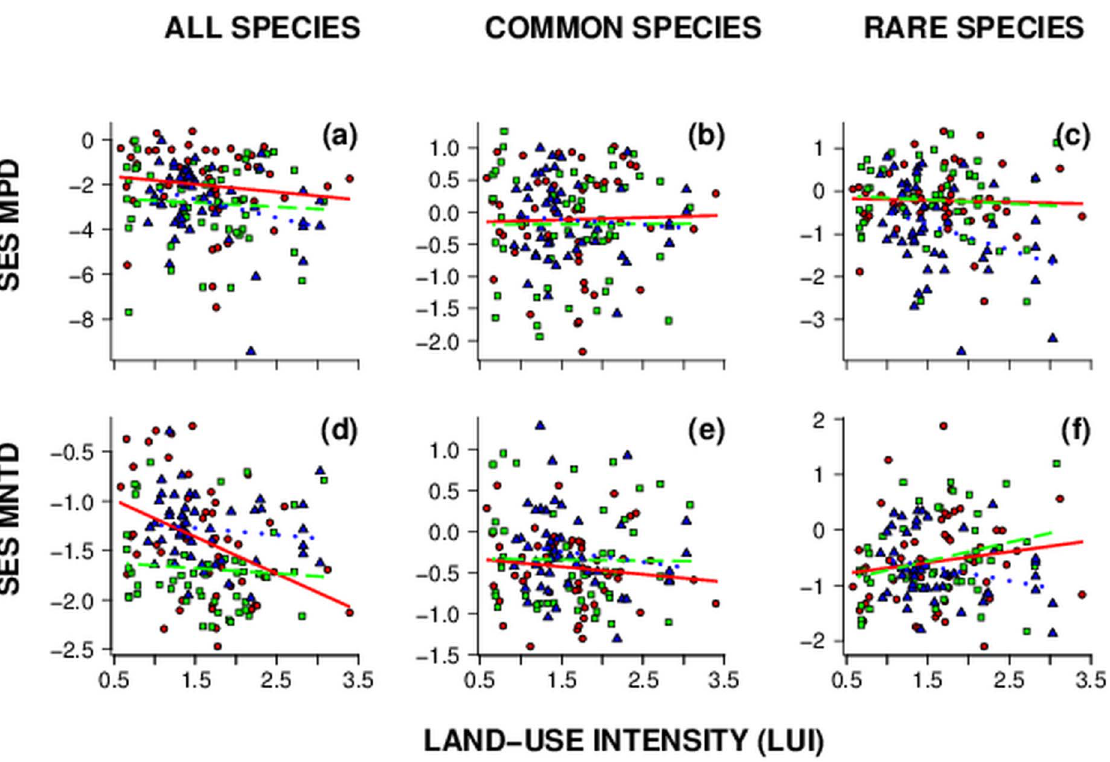
Figure 2. Relationships between mean pairwise distance (effect size MPD), mean nearest taxon distance (effect size MNTD) and land-use intensity (LUI) in three regions in Germany. Linear regression plots showing regression slopes for relationships between (a–c) mean pairwise distance and (d–f) mean nearest taxon distance for total, common and rare species assemblages and land-use intensity (LUI). Color and type code: red solid line/circle=Schwa¨bische Alb (Alb); green dashed line/square=Hainich-Du¨n (Hai); blue dotted line/triangle=Schorfheide-Chorin (Sch). Note different scales of y-axes. For significance of regression slopes see Appendix S4.